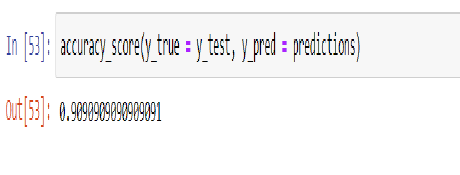
Figure 2. Scatter plots for linear regression model